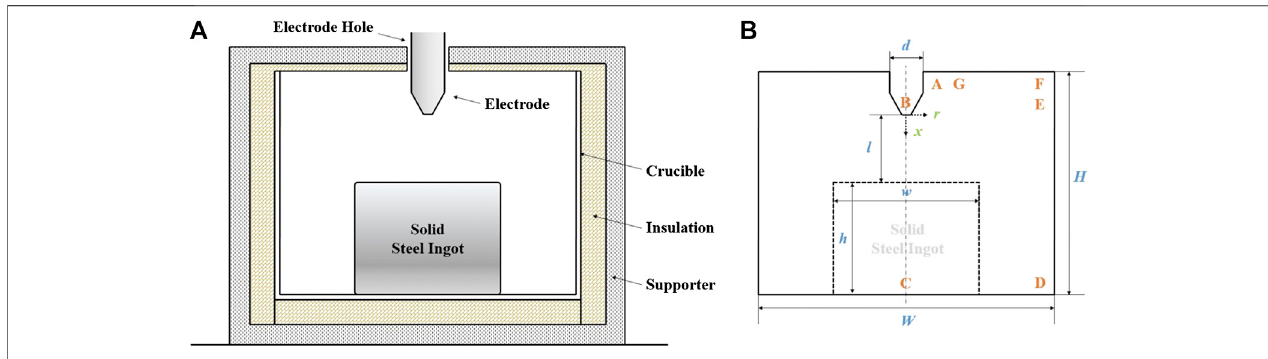
FIGURE 1 | (A) Schematic diagram of the lab-scale arc melting furnace. (B) Computational domain for steel ingot melting by the electric arc.